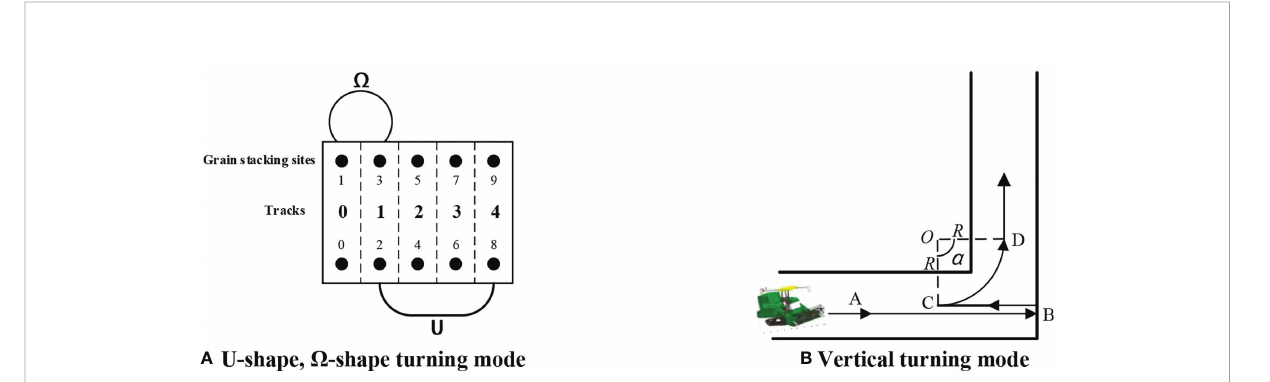
FIGURE 5 Turning mode (A) U-shape, W -shape turning mode (B) Vertical turning